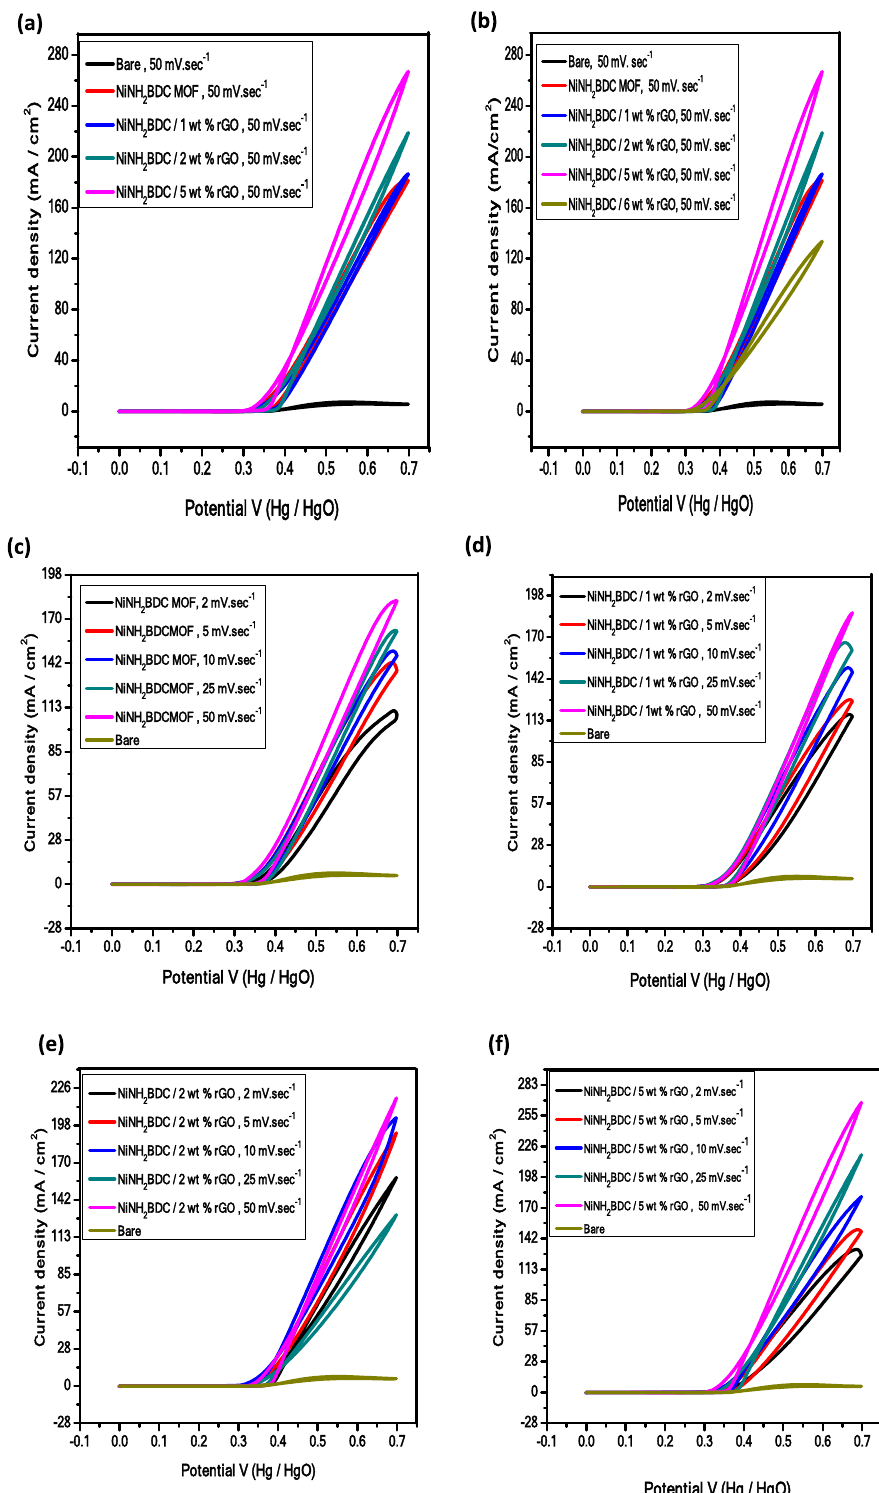
Figure 8. Cyclic Voltamogram of ( a ) NiNH 2 BDC MOF/1–5 wt% reduced graphitic carbon hybrids at 50 mV/s ( b ) NiNH speed 2–50